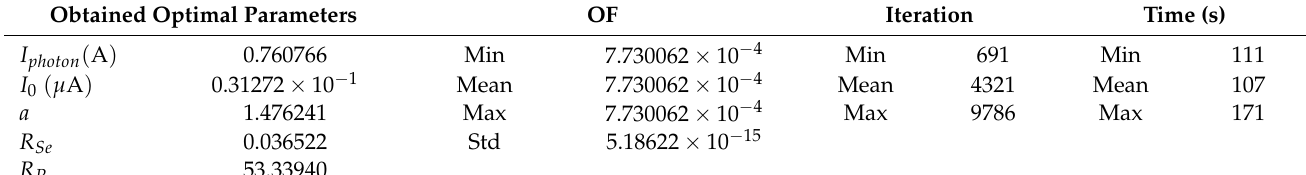
Table 4. Obtained statistical results for the SDM solar cell.